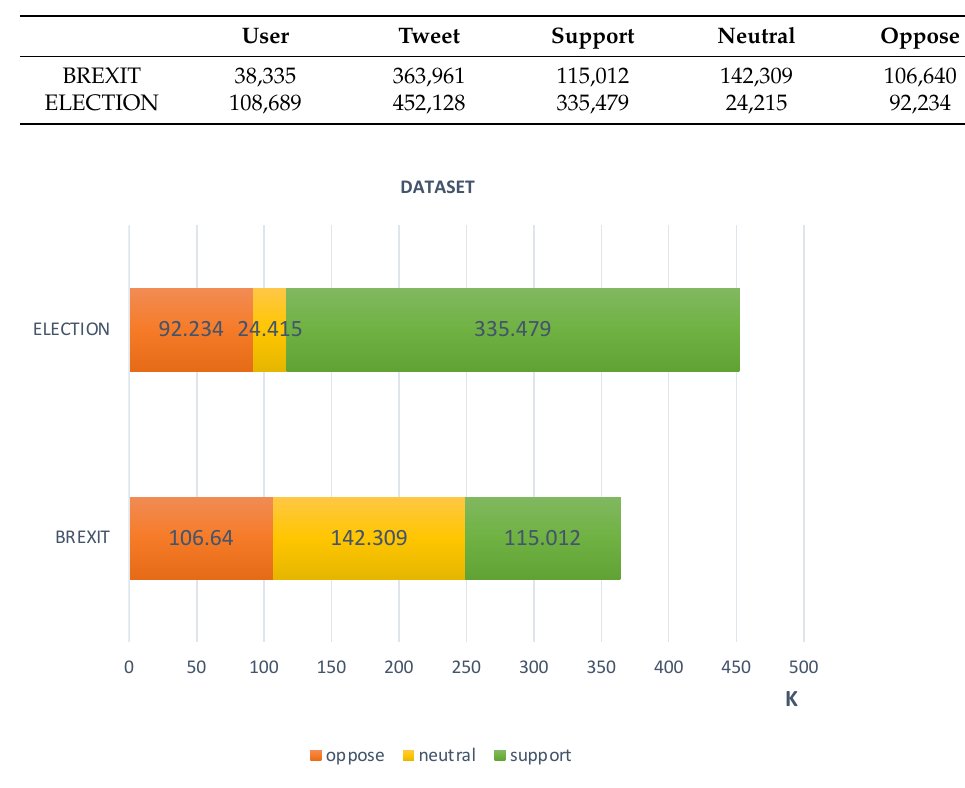
Table 2. Statistics of the two datasets.